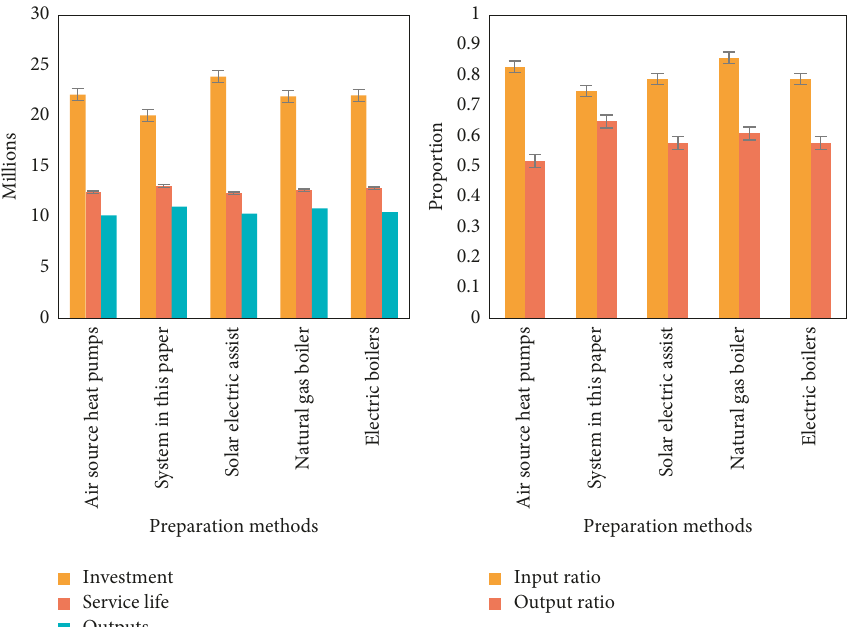
Figure 7: Economic benefits of different preparation